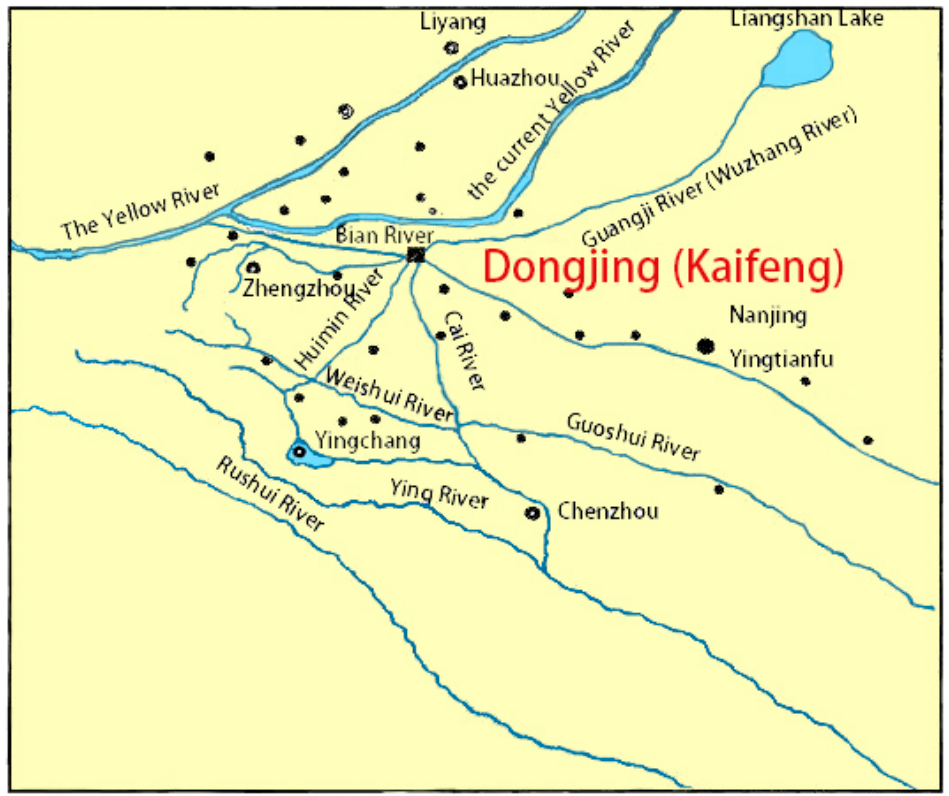
Figure 5. Radial canal net surrounding Kaifeng, the capital of the Northern Song Dynasty. (Map developed by the authors—https://m.sohu.com/a/230859384_556504, accessed on 2 July 2021).